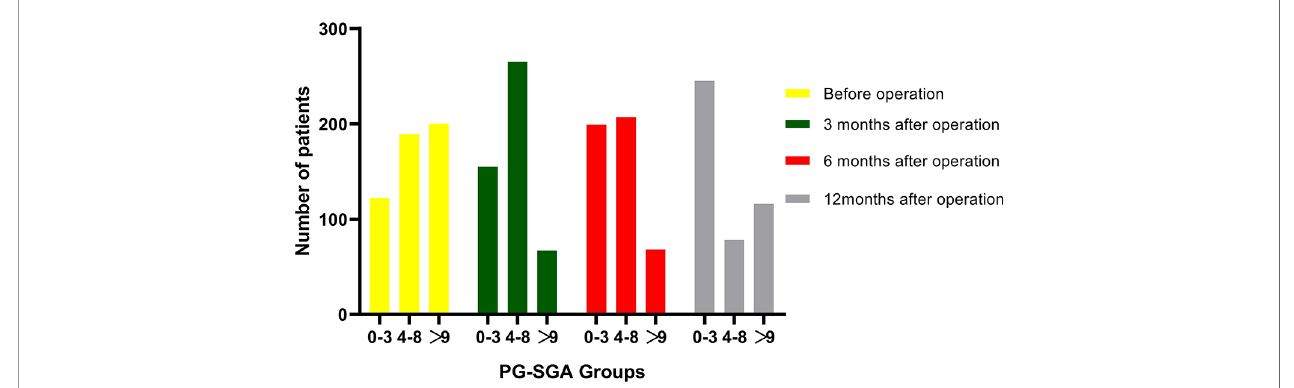
FIGURE 2 | Changes in patients number in PG-SGA groups over time from before to 3, 6, and 12 months after pancreatoduodenectomy. A total of 122, 155, 199, and 245 patients were classi fi ed into well-nourished group (0 – 3 scores) before surgery and at 3, 6, and 12 months after operation, respectively; 189, 265, 207, and 78 patients were classi fi ed into moderately malnourished group (4 – 8 scores) before surgery and at 3, 6, and 12 months after operation, respectively; and 200, 67, 68, 116 patients were classi fi ed into severely malnourished group (>9 scores) before surgery and at 3, 6, and 12 months after operation, respectively.